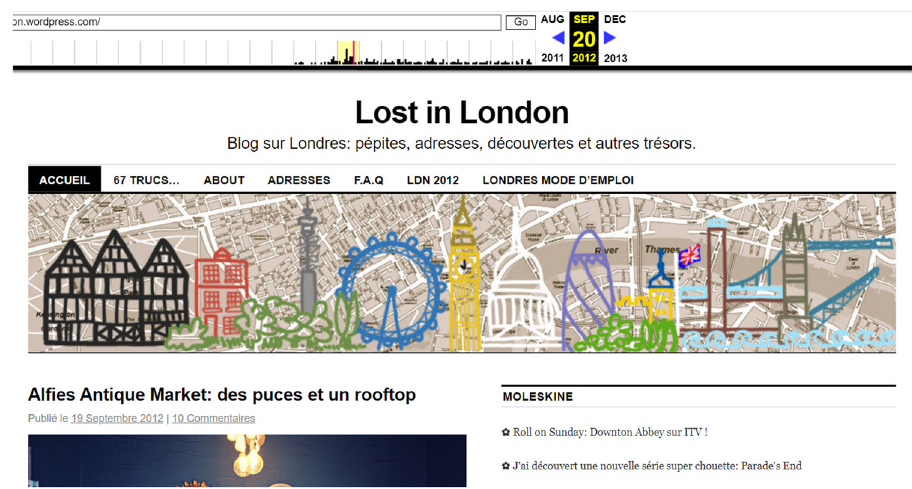
Fig. 4 Lost in London homepage, archived 20 September 2012. The banner has again been redesigned: the photographs have been replaced by a semiotically complex ‘ drawing ’ and the tabs now merge French and English. This fi gure is not covered by the Creative Commons Attribution 4.0 International License. Reproduced with permission of Fabienne Henry; copyright ©Fabienne Henry, all rights reserved.